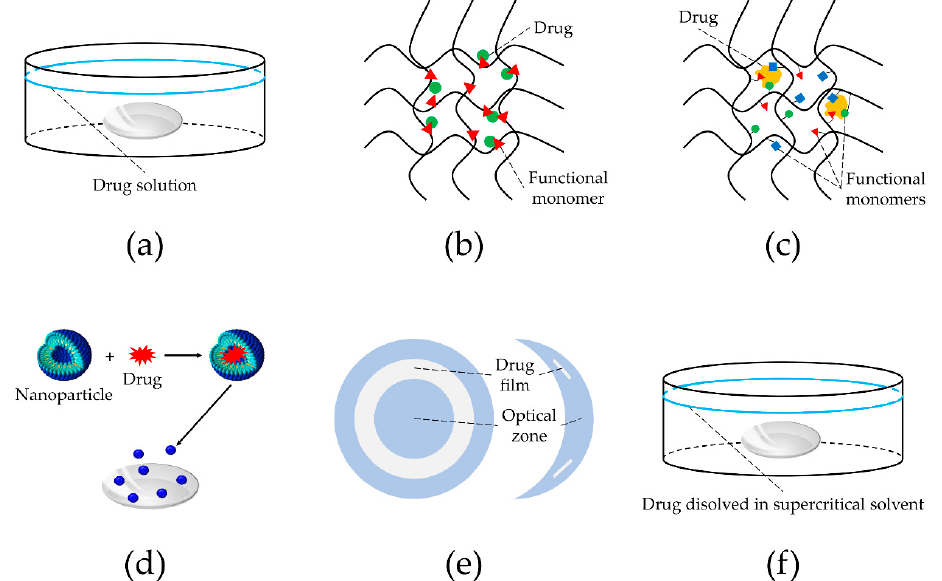
Figure 1. Representative image of the different methods to load drugs into soft contact lenses: soaking ( a ), functional monomers ( b ), molecular imprinting ( c ), colloidal nanoparticles ( d ), drug-polymer film embedded ( e ), and supercritical fluid ( f ). Each method is explained in sections from 2.1 to 2.6.